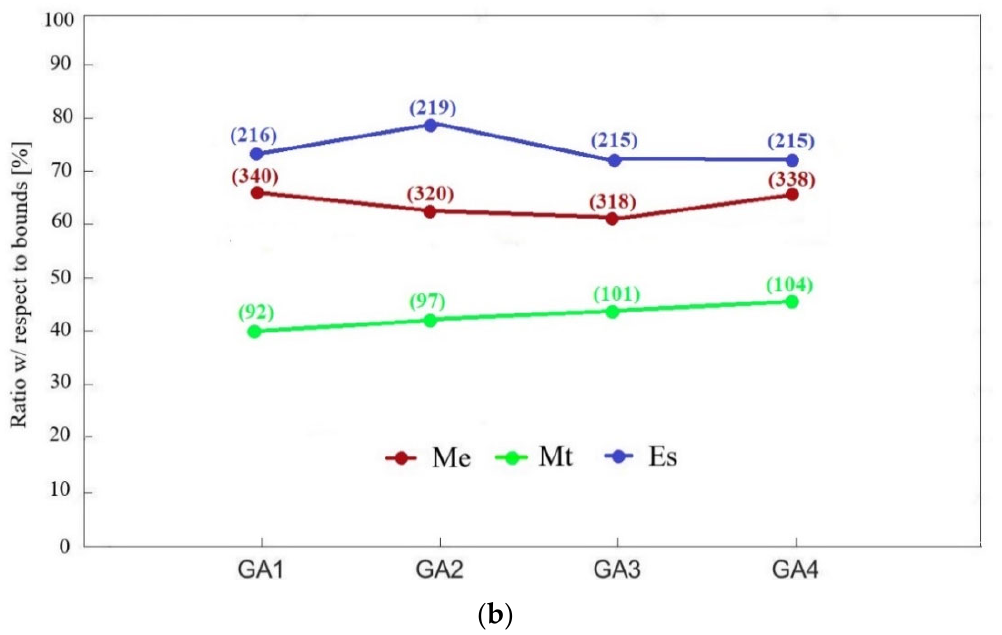
Figure 14. Values of the optimal parameters for the optimization runs GA1–GA4 for the unloaded vehicle numerical model: ( a ) stiffness parameters, ( b ) additional mass parameters and steel deformability modulus.